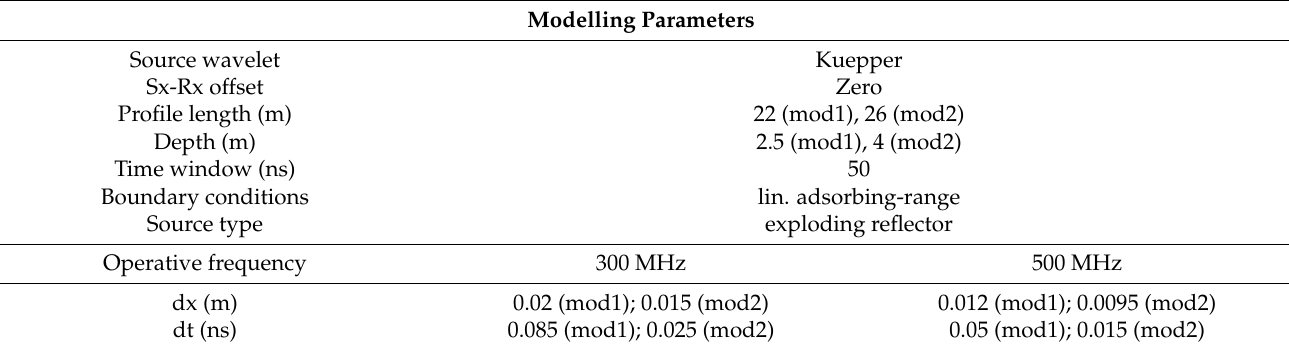
Table 2. Parameters used for GPR modelling.